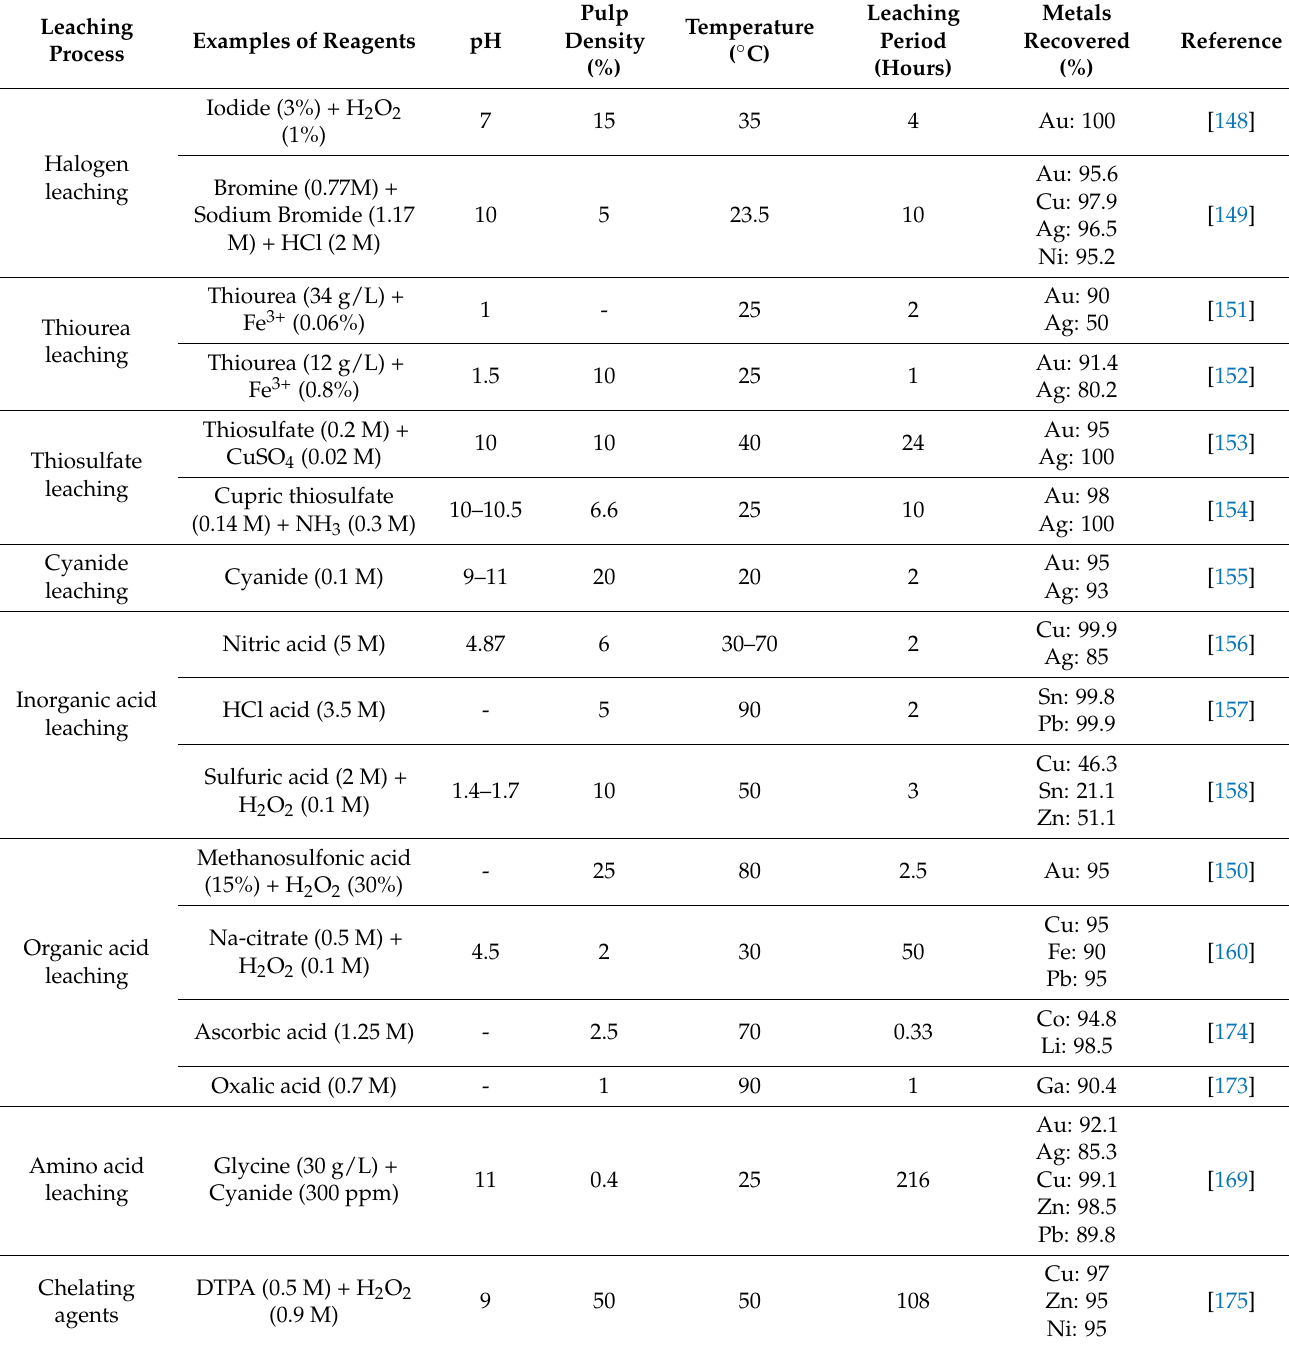
Table 5. Overview of leaching agents used in hydrometallurgy as well as the process